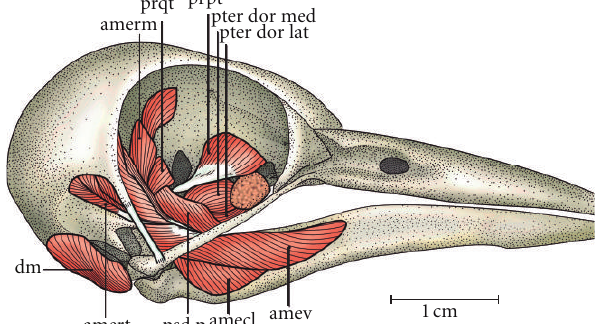
Figure 2: A lateral superficial view of the jaw muscles of Picus miniaceus. amecl: adductor mandibulae externus caudalis lateralis; amerm: adductor mandibulae externus rostralis medialis; amert: adductor mandibulae externus rostralis temporalis; amev: adductor mandibulae externus ventralis; dm: depressor mandibulae; prpt: protractor pterygoidei; prqt: protractor quadrati; psd p: pseudotemporalis profundus; pter dor lat: pterygoideus dorsalis lateralis; pter dor med: pterygoideus dorsalis